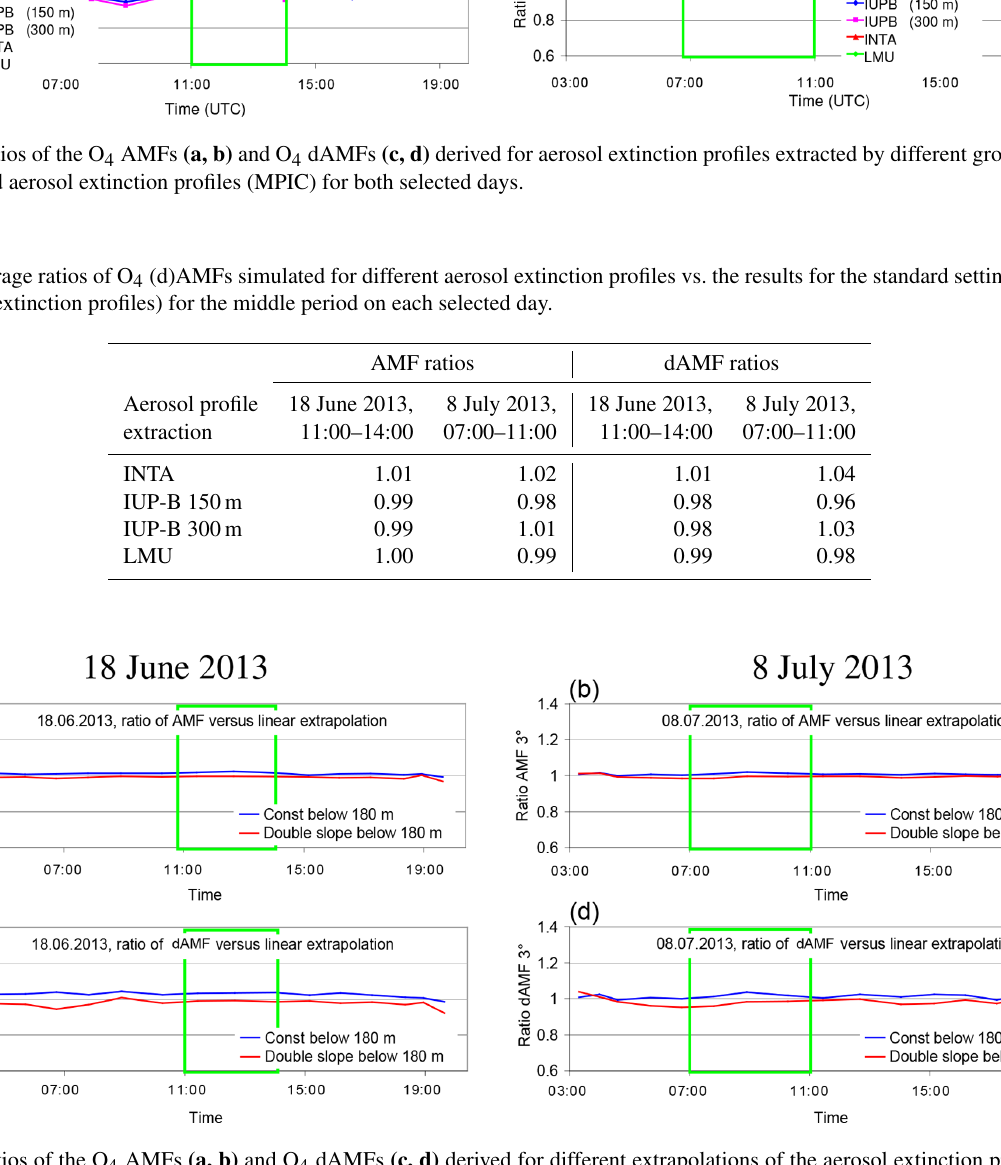
Figure A8. Ratios of the O 4 AMFs (a, b) and O 4 dAMFs (c, d) derived for different extrapolations of the aerosol extinction profiles below 180m vs. those for the standard settings (linearly extrapolated profiles) for both selected